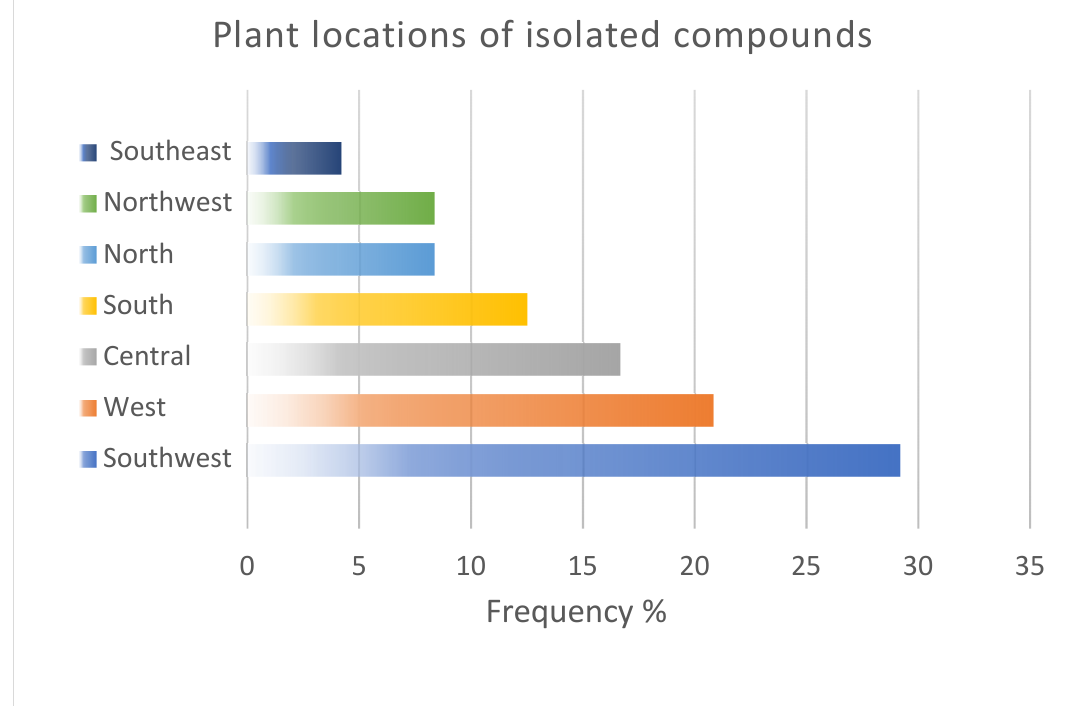
Figure 7. Common plant locations, as described in this review.